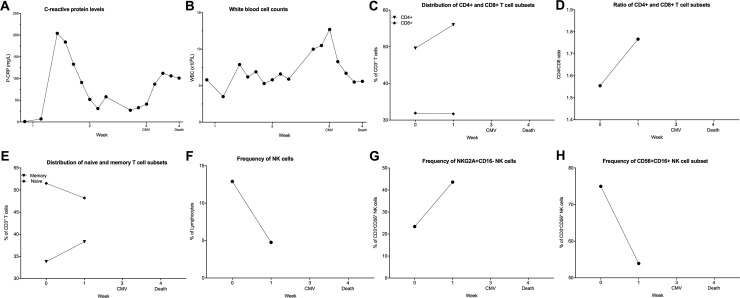
Clinical and immunological parameters from an 82y male patient with CMV reactivation during dara treatment.(A-B): The laboratory parameters CRP (A) and WBC at admission during the Dara treatment and CMV reactivation until the death of the patient are shown. (C-H) Peripheral blood samples were collected from patients throughout the Dara treatment. PBMCs were stained with lymphoid lineage markers and analyzed by flow cytometry, as described in experimental procedures. Frequencies of T cell and NK cells subsets are depicted. (C) percentages of CD8+ and CD4+ T cells and (D) CD4/CD8 ratio during Dara treatment (E) distribution of memory (CD45RA-CD45RO+) and naïve (CD45RA+CD45RO-) T cell subpopulation. In (F), total CD3-CD56+ NK cells as the percentage of lymphocytes and (G) CD56+CD16-NKG2A+ NK cells as the percentage of CD3-CD56+ NK cells are shown. (H) shows frequency of CD56+CD16- as the percentage of total CD3-CD56+ NK cells.